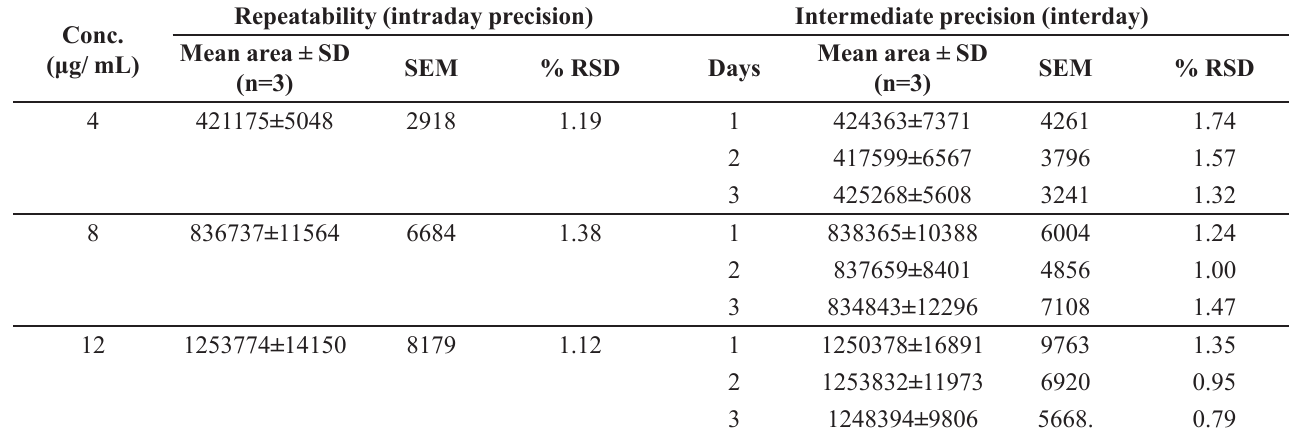
TABLE III - Reproducibility of proposed method Conc. (μg/